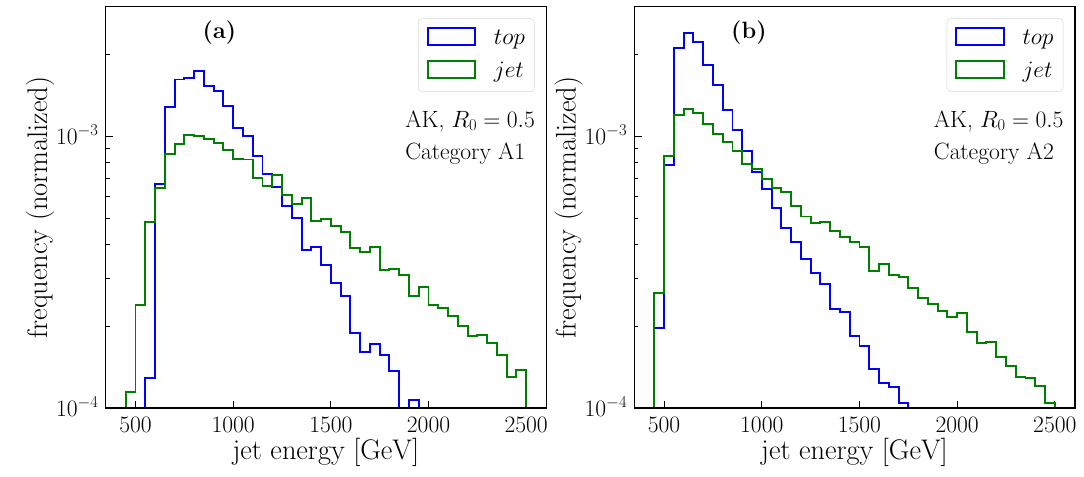
Figure 3 . Normalized distribution of jet energy for categories (a) A1 and (b) A2. The blue and green histograms are respectively for the reconstructed top and the high- p